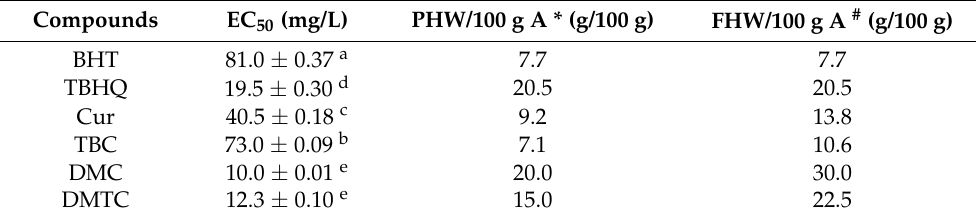
Table 1. The EC 50 values and the weight of phenolic or functional hydroxyl groups per 100 g of the antioxidant